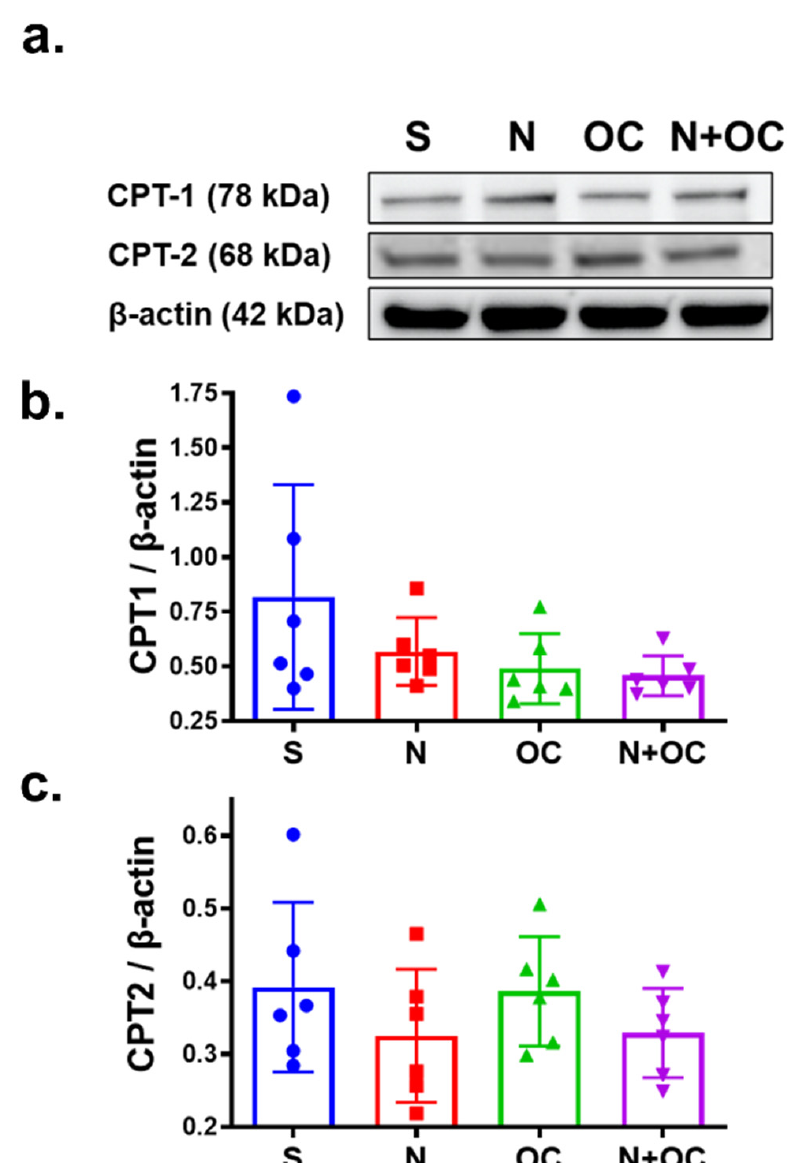
Figure 4. Immunoblotting of key enzymes involved in fatty acid metabolism, and in particular, β -oxidation. ( a ) Immunoblots show steady-state protein levels of carnitine palmitoyltransferase I (CPT1) and carnitine palmitoyltransferase II (CPT2) in the cortex of saline-, N-, OC-, and N + OC-exposed rats. β -actin was the loading control. ( b , c ) Western blot analysis demonstrates lower steady-state levels of CPT1 and CPT2 in N- and N + OC-exposed rats as compared to saline-exposed rats; however, the differences are not significant.